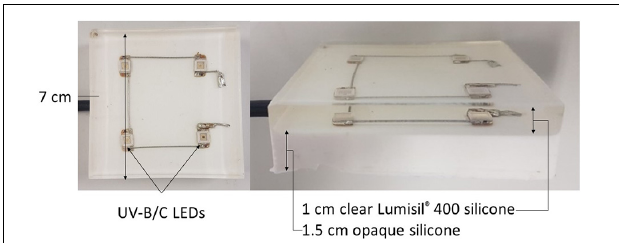
FIGURE 1 | Four low powered (24-volt, 0.17 amp) UV-B/C LEDs arranged in a 2 × 2 array on a 1.5 cm thick opaque silicone polymer and embedded in a 1 cm thick UV transparent Lumisil R (cid:13) 400